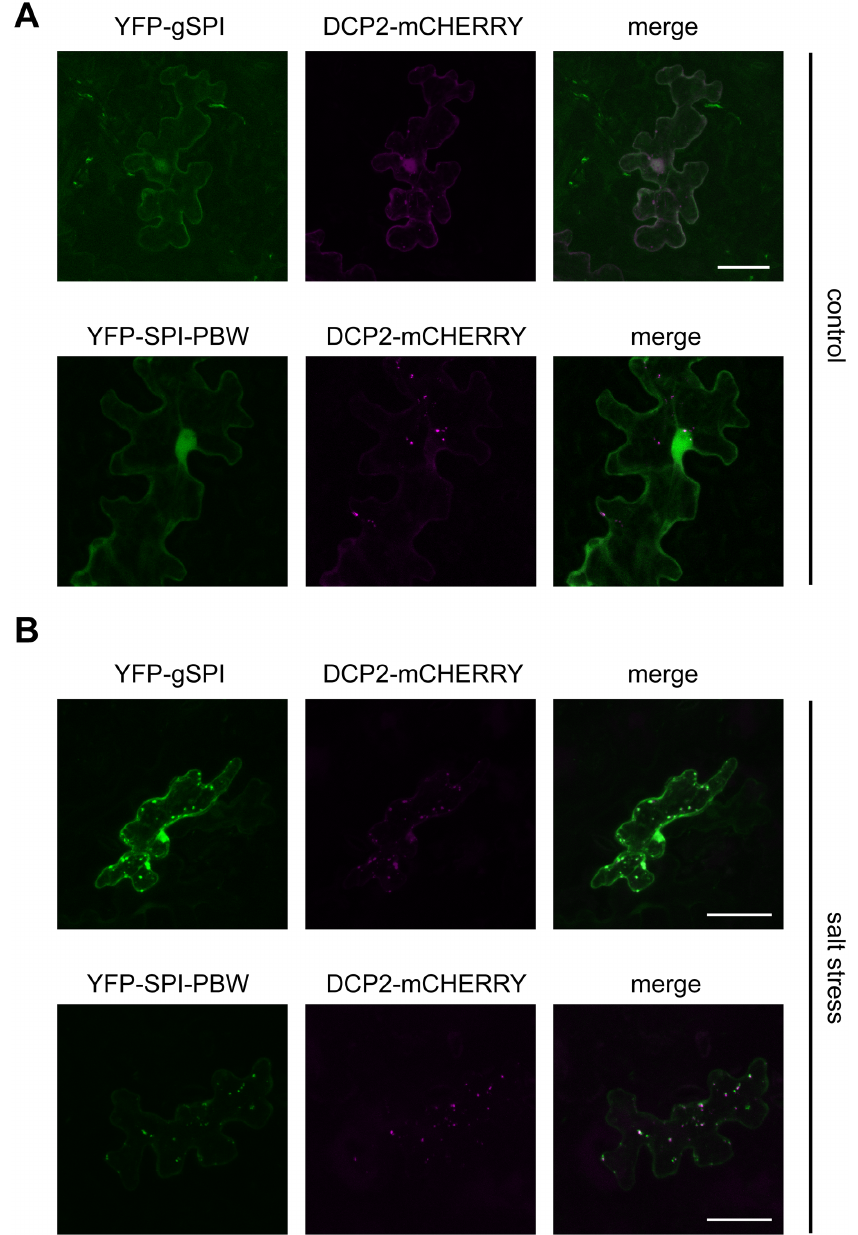
Fig 3. Colocalization studies with YFP-fusions of SPI (column I) and DCP2-mCHERRY-labeled P- bodies (column II) in transiently transfected Arabidopsis leaf epidermis cells. Column III presents the overlay picture between columns I (green) and II (magenta). (A) Under nonstress conditions, YFP-gSPI (upper row) and YFP-SPI-PBW (lower row) are evenly distributed throughout the cytoplasm. (B) YFP-gSPI (upper row) and YFP-SPI-PBW (lower row) accumulate at DCP2-mCHERRY-labeled P-bodies after incubation of transfected leaves on ½ Murashige and Skoog (MS) medium supplemented with 140 mM NaCl for 10 h. Scale bar: 25 μ